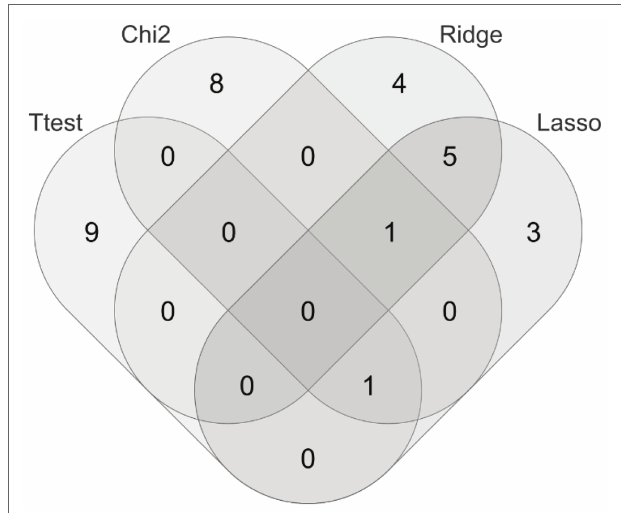
was slightly larger than that (15.9508) of Ridge, as shown in Figure 4B . The filter Ttest was assigned the Aim 10.6090 due to its largest SD 0.0877.